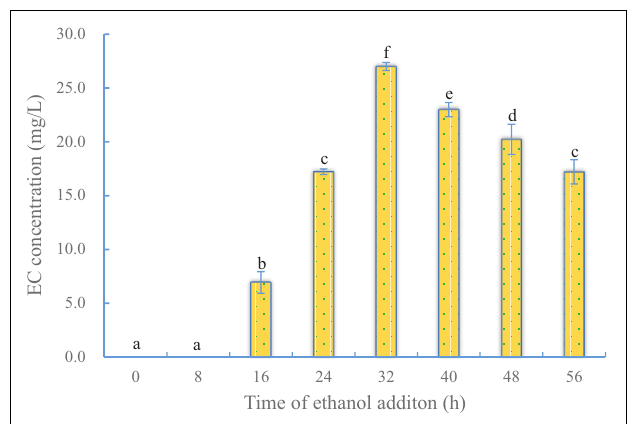
FIGURE 4 | Effect of time of ethanol addition on EC production by YX3307. Same letters in the column indicates that the data do not differ significantly at 5% probability by the Tukey test.